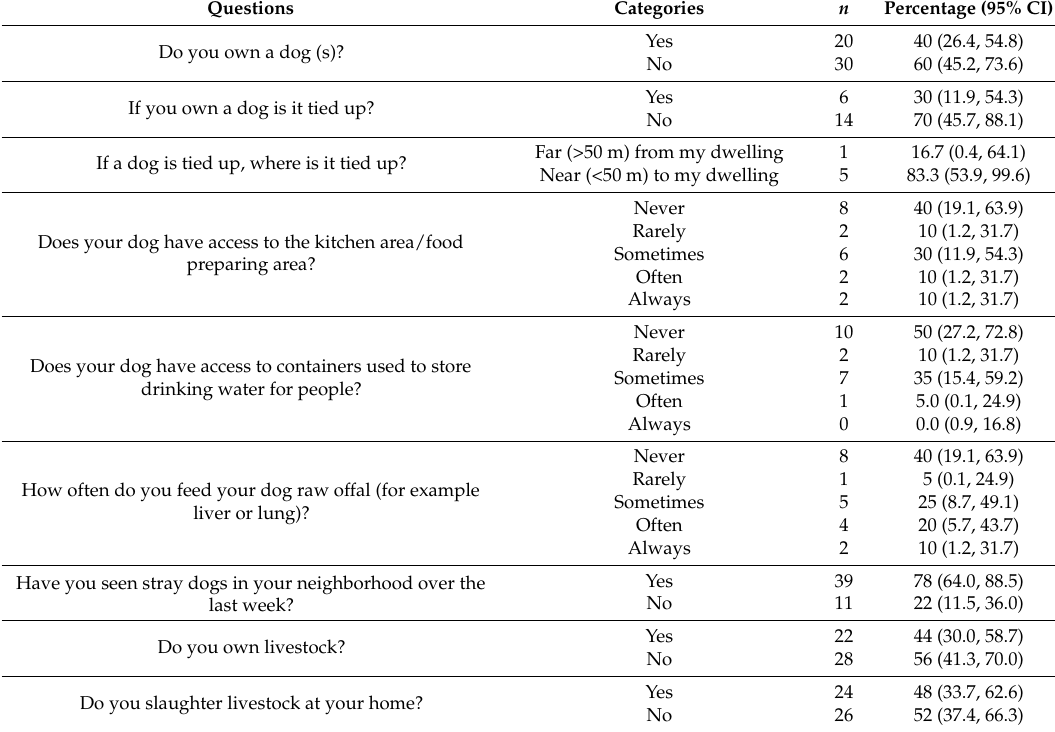
Table 3. Descriptive self-reported practices toward cystic